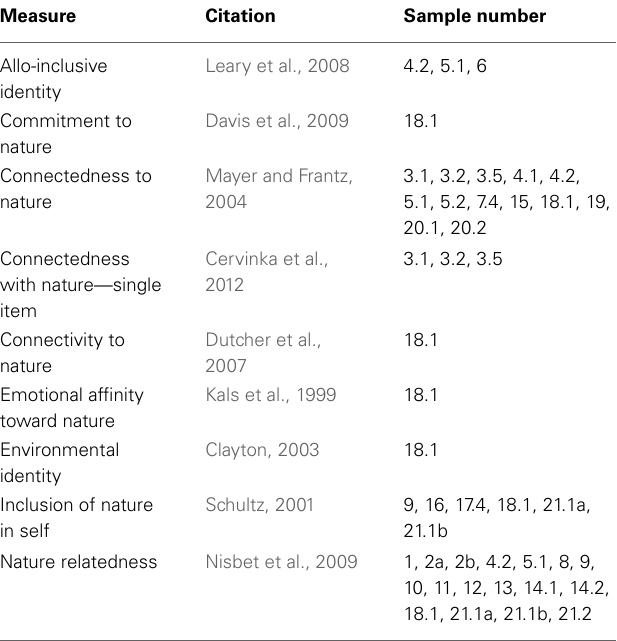
Table 1 | Nature connectedness measures included in